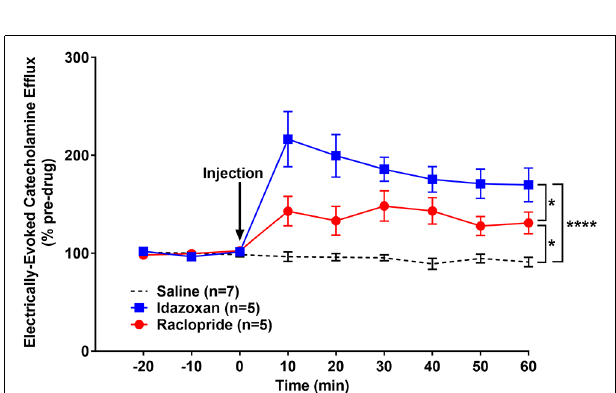
FIGURE 6 | Idazoxan and raclopride significantly increased norepinephrine and dopamine, respectively, in the basolateral amygdala (BLA) following locus coeruleus (LC) electrical stimulation in rats exposed to a forced swim test (FST). Rats exposed to a forced swim test were anesthetized and used to quantify LC-evoked CA release in the BLA, as measured by fast-scan cyclic voltammetry. After a stable baseline was established, saline, idazoxan, or raclopride was administered (black arrow). Idazoxan and raclopride resulted in a significant increase in the measured signal compared to the saline control. Efflux values are presented as mean ( ± SEM) percent of a pre-injection baseline average. Saline: n = 6; Idazoxan: n = 5; Raclopride: n = 5. * p < 0.05; ** p <